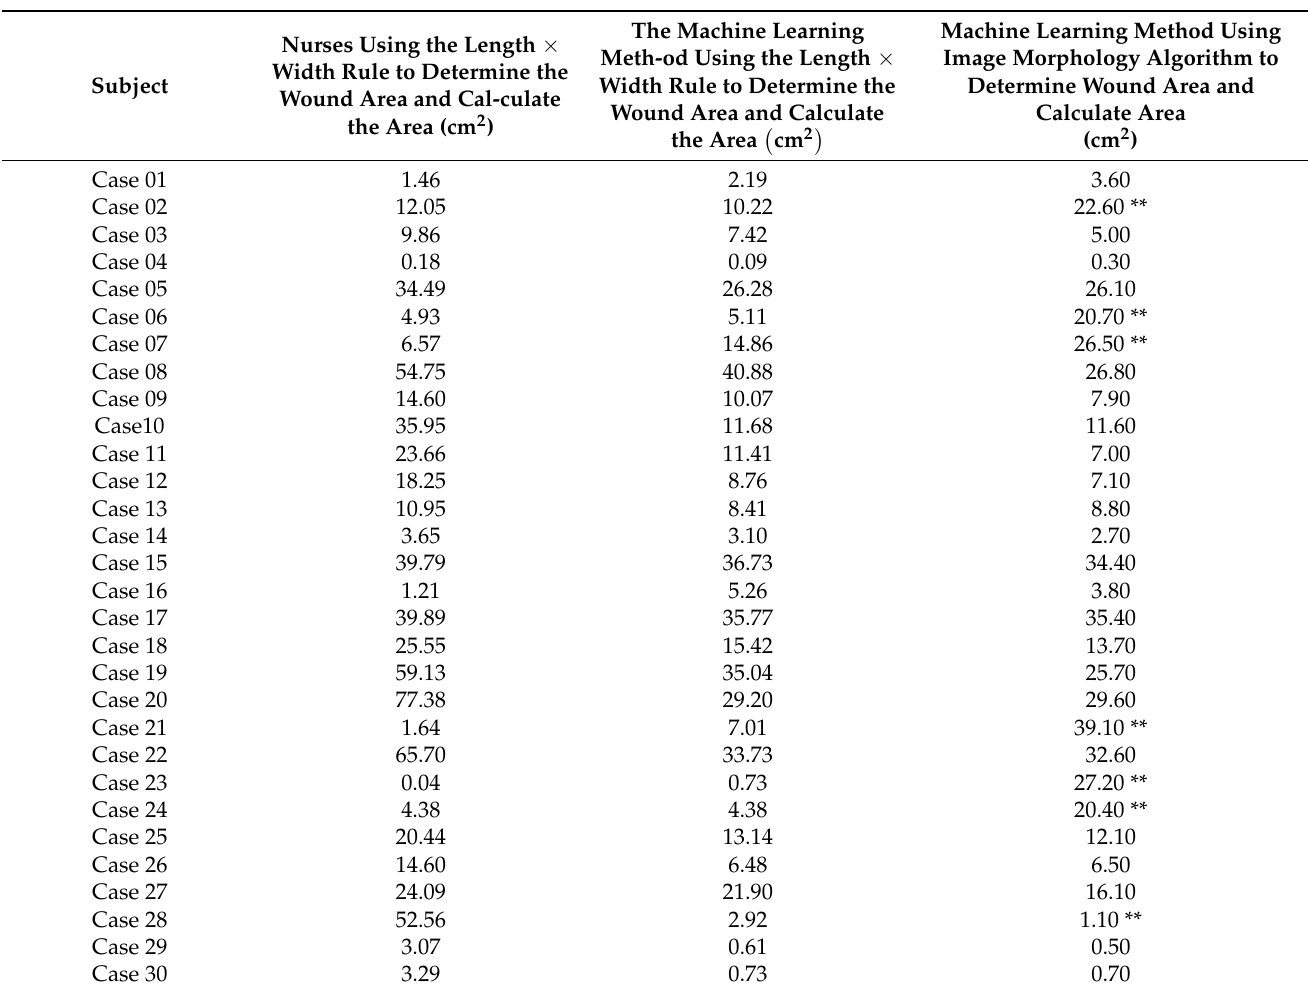
Table 3. The traditional length × width rule, machine learning with the length × width rule, and wound area information calculated by the image morphology algorithm.